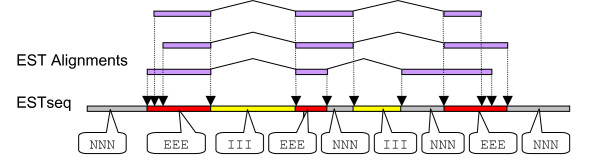
Construction of ESTseq from EST alignments. Each row of purple bars represents the aligned blocks of one EST, while the thin lines connecting the bars represent implied introns. The ESTseq representation contains an "E" for each base that is indicated as exonic (red), an "I" for each base that is indicated as intronic (yellow), and an "N" for each base that lies outside of all the alignments (gray). Regions that are indicated as intronic by some alignments and exonic by others are also labeled "N".